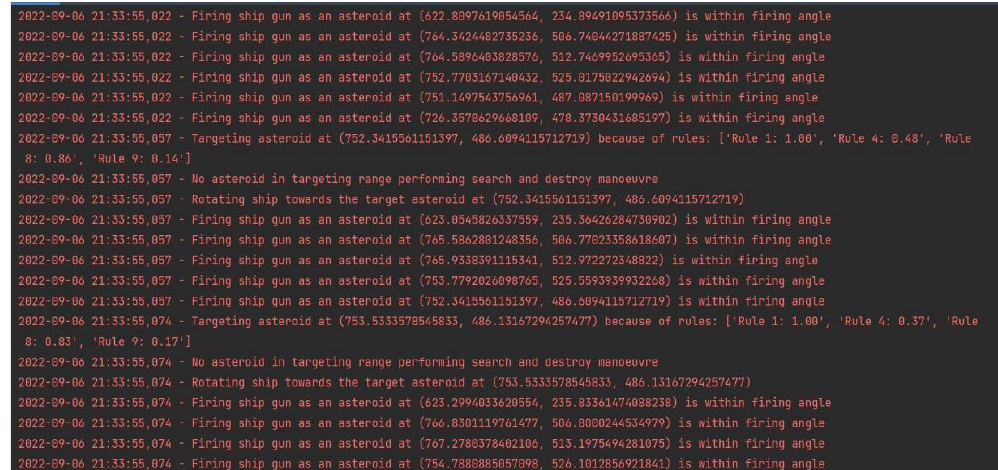
Figure 12. XAI agent explanations.